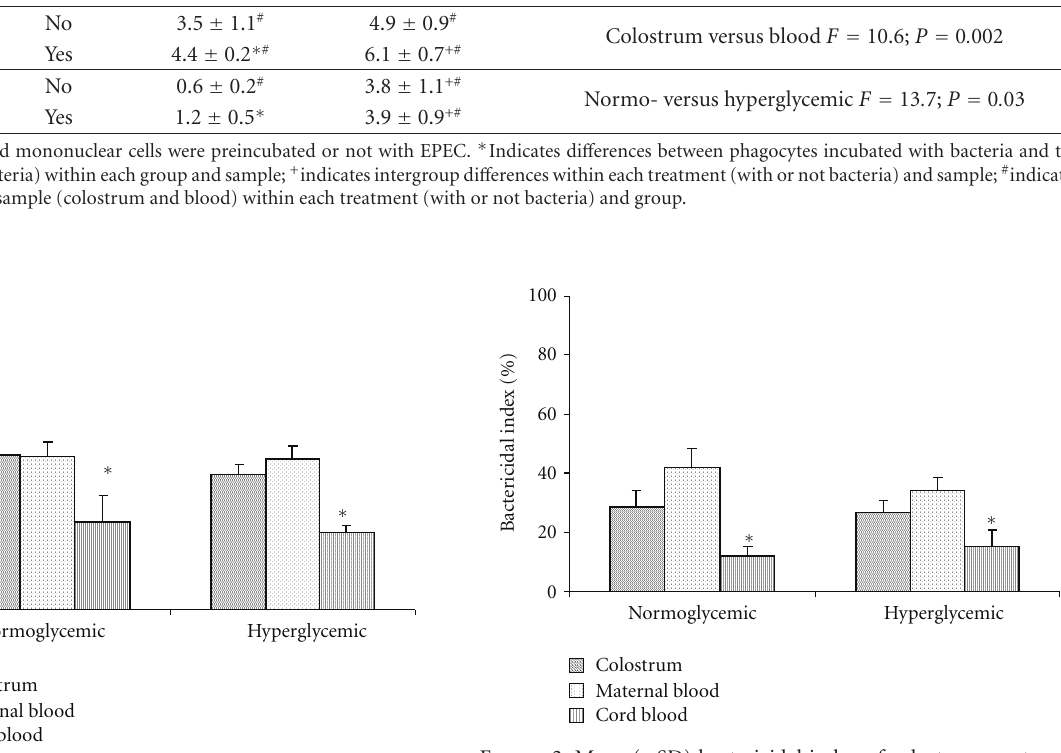
Figure 1: Mean ( ± SD) phagocytosis index of colostrum, maternal, and cord blood MN cells ( N = 10) determined using the acridine orange method. ∗ Indicates statistical di ff erence ( P < 0 . 05) within normo- and hyperglycemic groups.